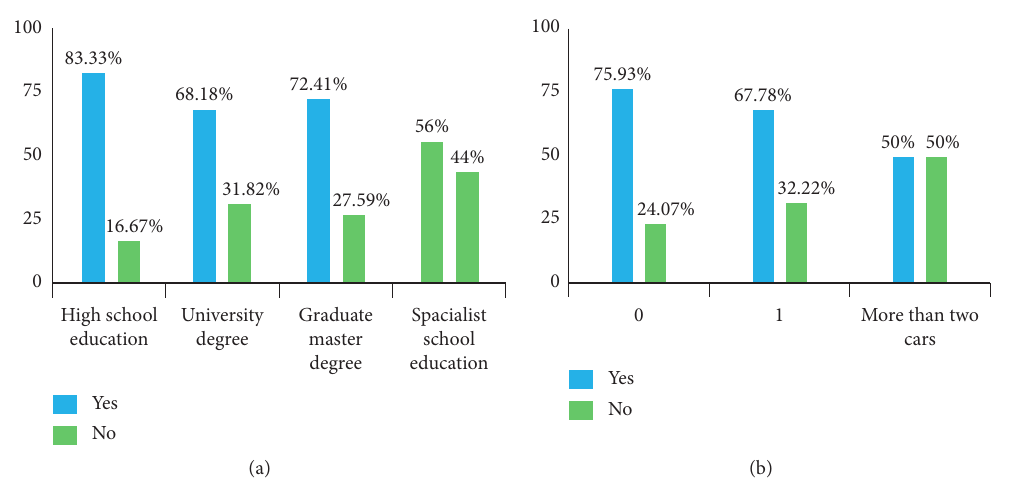
Figure 3: Breakdown of choice behavior according to education and private car ownership.